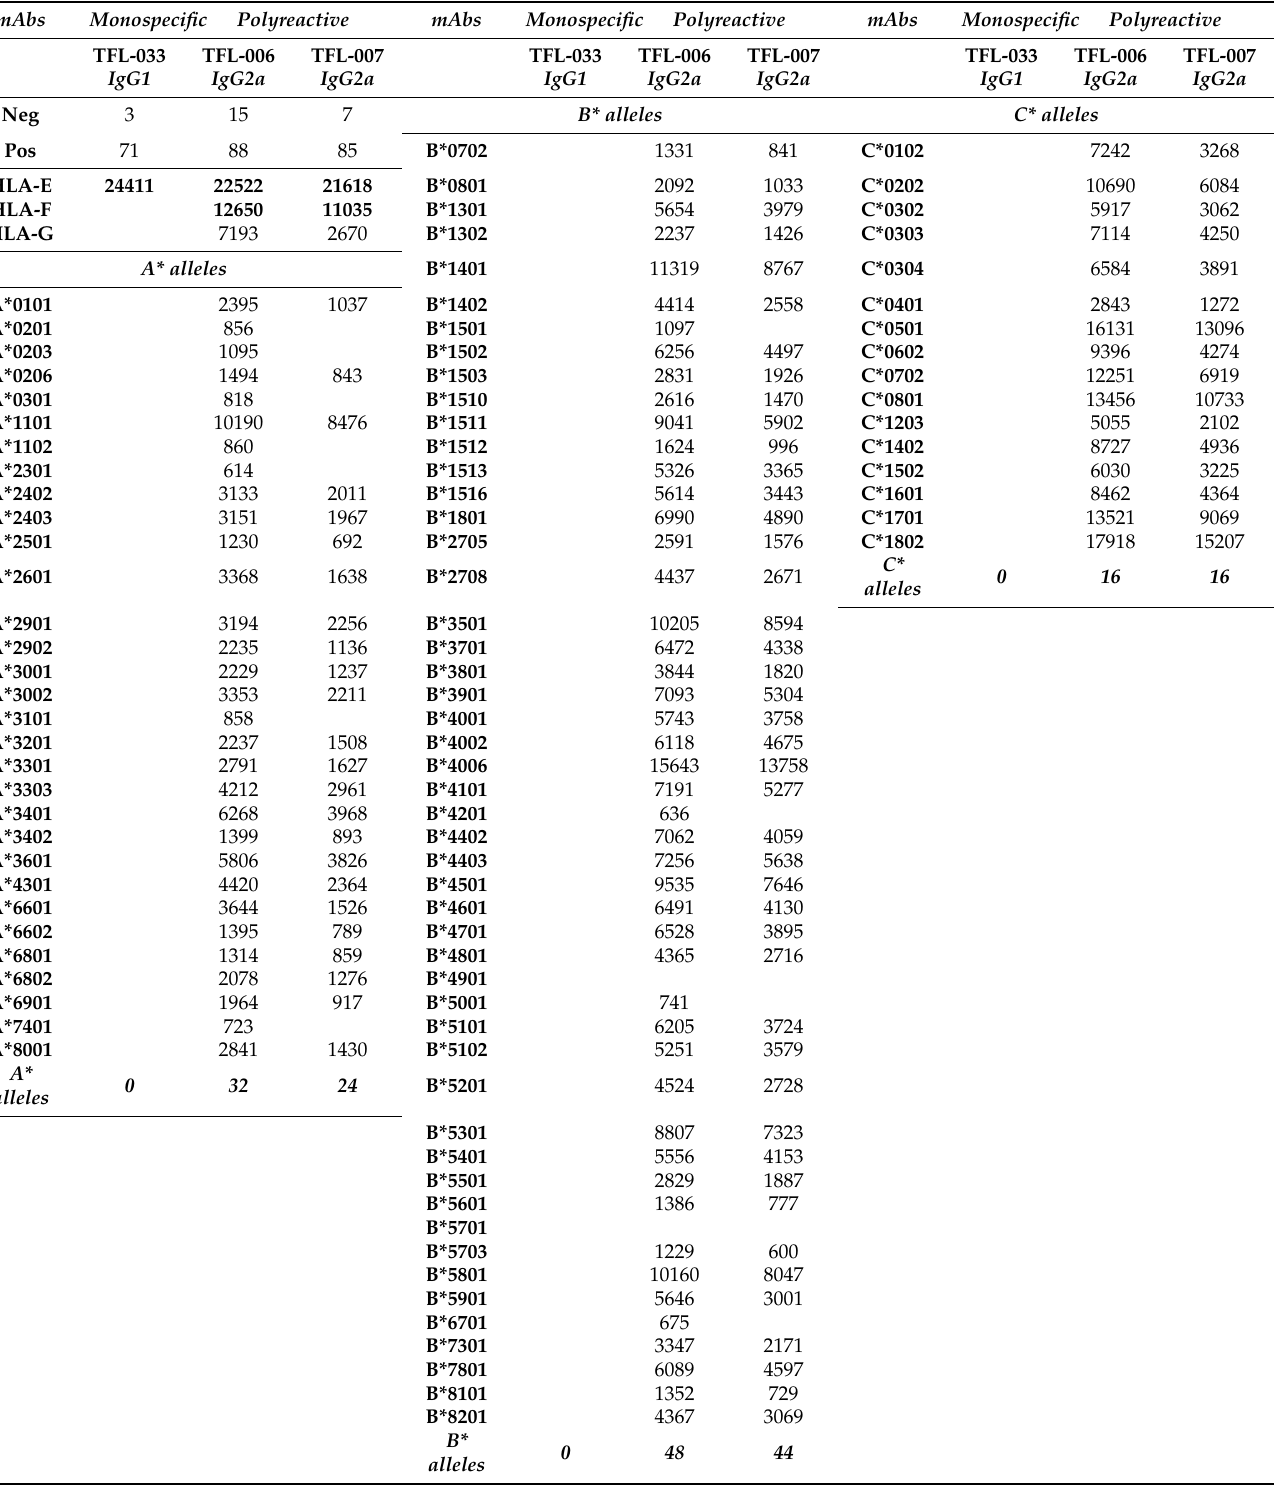
Table 4. HLA-I allele reactivities of the polyreactive mAbs as compared with monospecific mAbs. The values represent mean fluorescent intensities (MFIs) of the mAbs, corrected against background values. The mAbs were generated using HLA-E-recombinant heavy chains. The number of HLA antigens showing positive reactivity with the mAbs are shown in bold